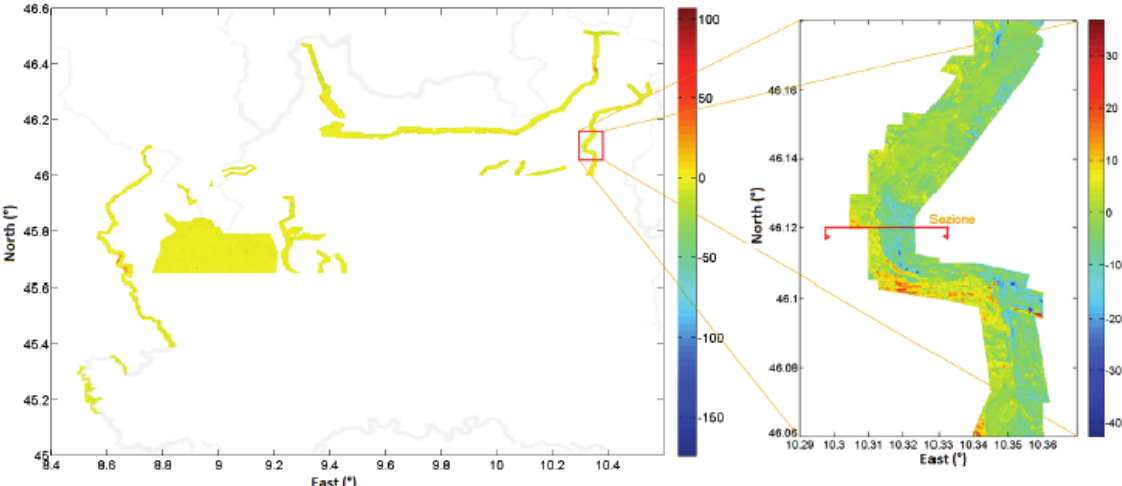
Figure 3. On the left: coverage of PST-A DTM and its differences with HD-1. At the right: a zoom of one example zone. Differences values in